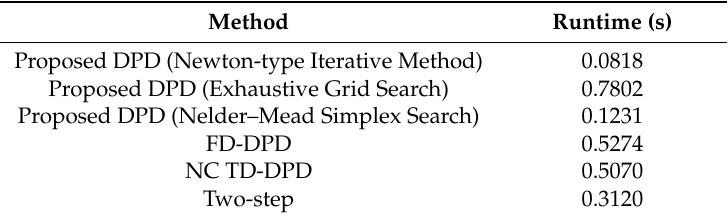
Table 2. Average runtime for near-field sources. FD, frequency domain; TD, time domain; NC, noncircular.